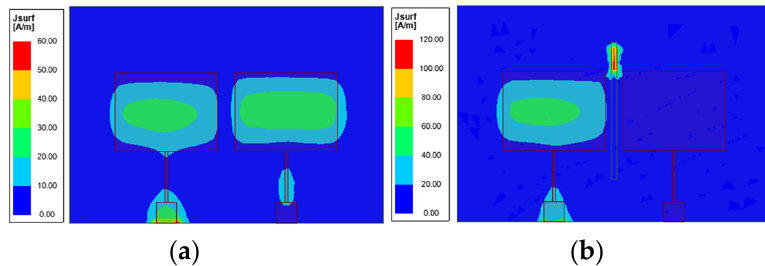
Figure 10. Current distributions before ( a ) and after ( b ) using the proposed structure.